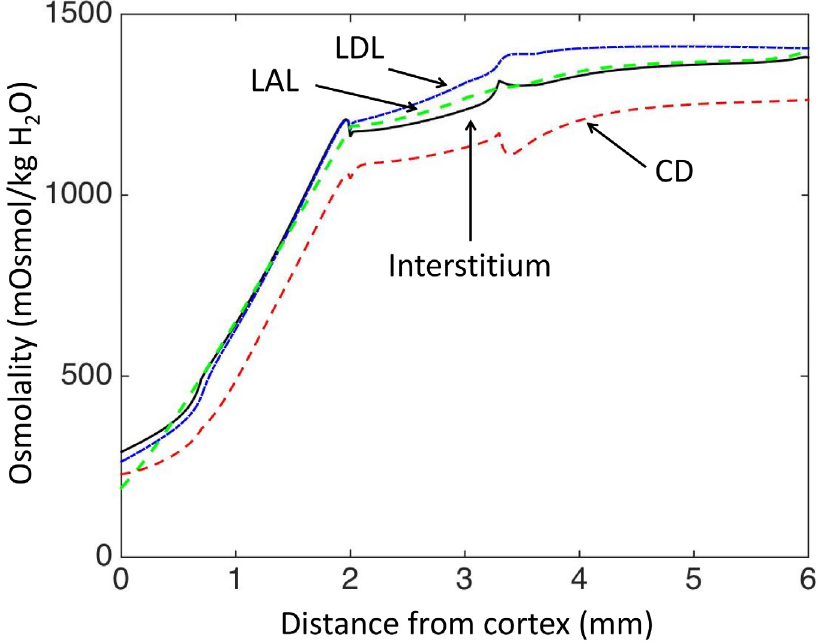
Fig 10. Model results (alternative baseline scenario): osmolality gradients (mOsm/KgH 2 O) obtained when the segments of the descending limbs are assumed to be water impermeable.